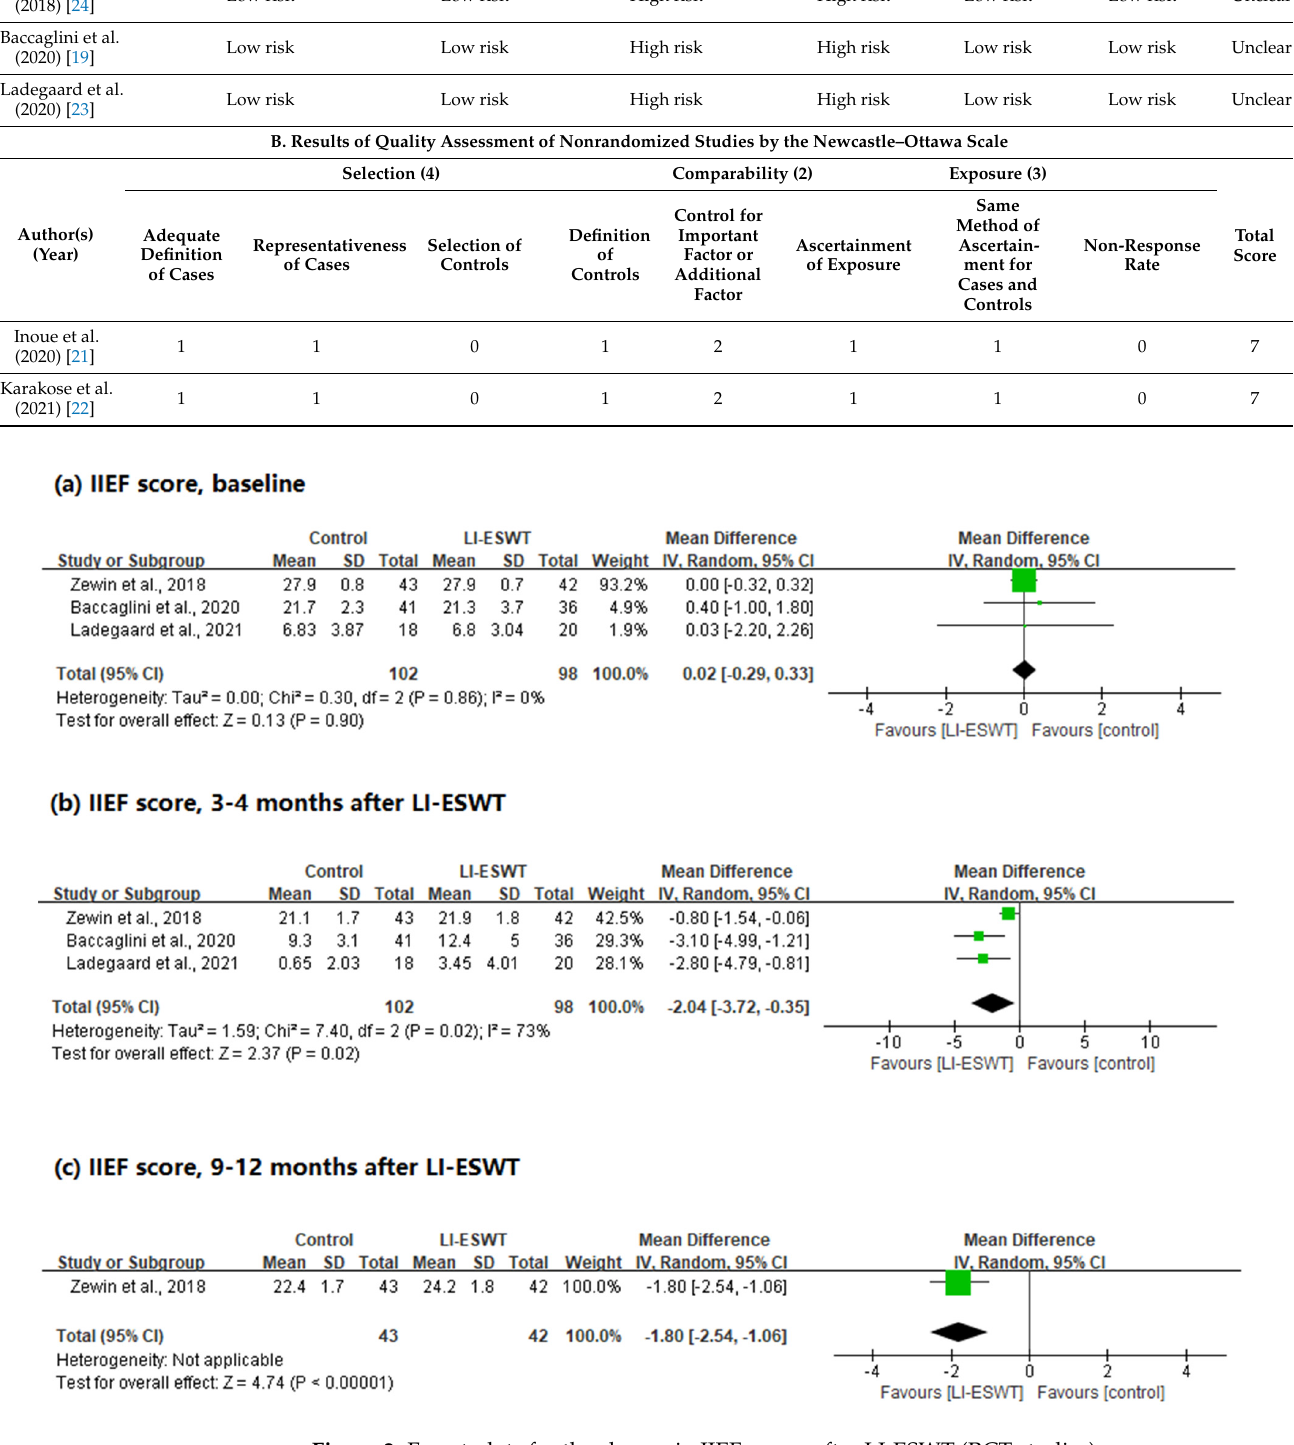
Figure 2. Forest plots for the change in IIEF scores after LI-ESWT (RCT